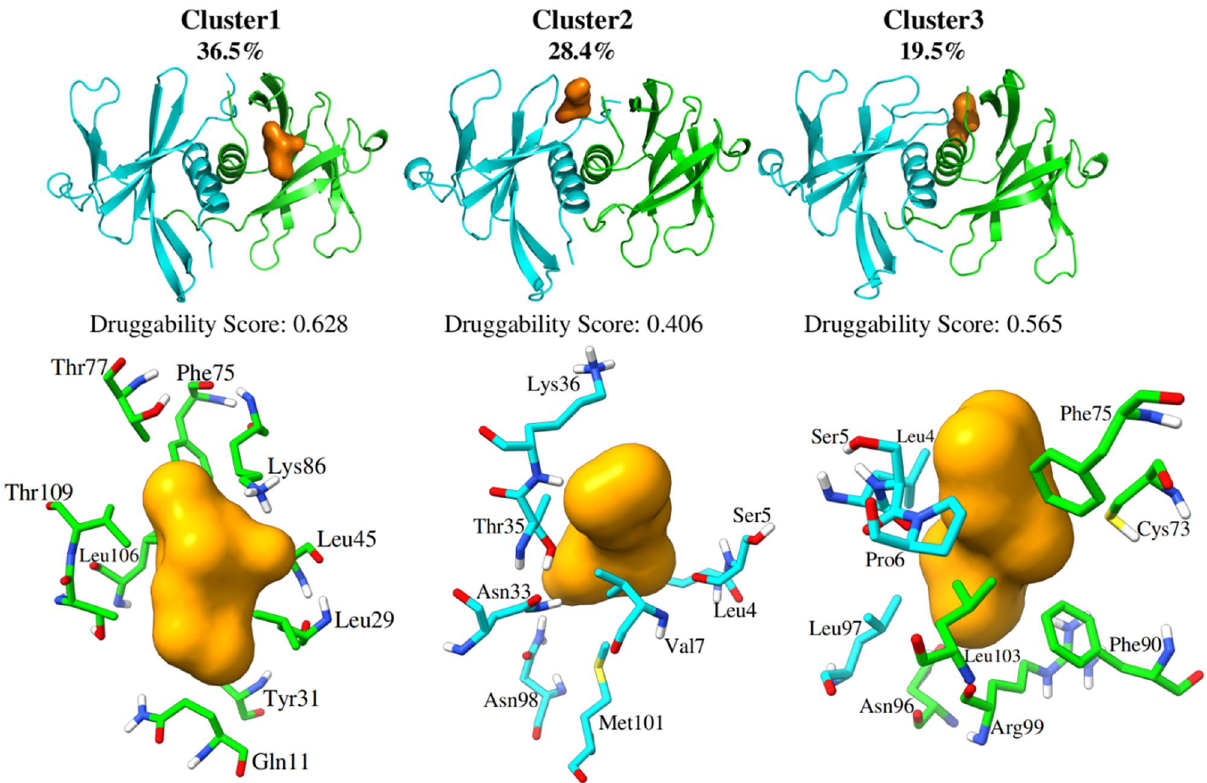
Figure 4. Representative structures of the clustering results for the native dimer showing the accessible cavities (orange surfaces) to drugs calculated with Fpocket. At the bottom, residues that form the cavities are presented in